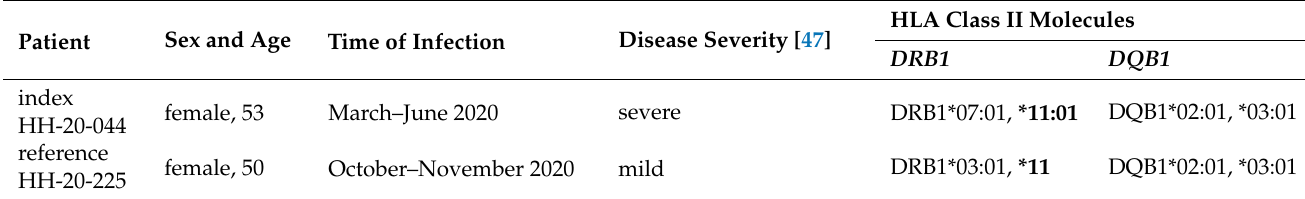
Table 1. Patient characteristics and